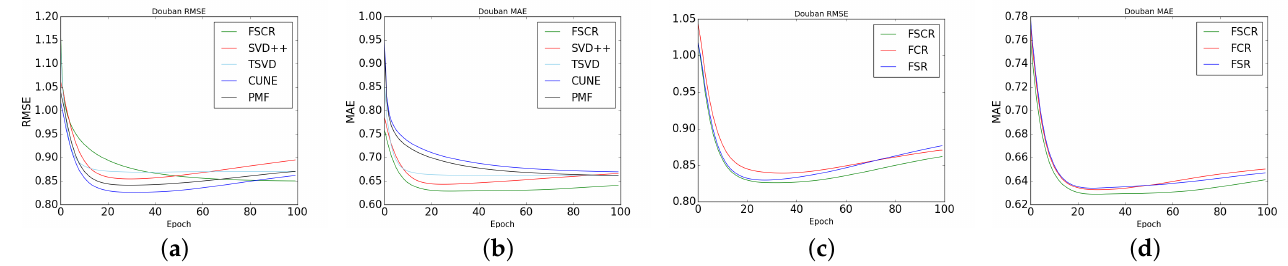
Figure 4. Compared with other baseline models, the FSR model (without introducing side information embedding, but with social influence diffusion layer), the lower the RMSE and MAE, the better the performance. ( a ) Douban RMSE, ( b ) Douban MAE, ( c ) FSCR RMSE, ( d ) FSCR MAE,